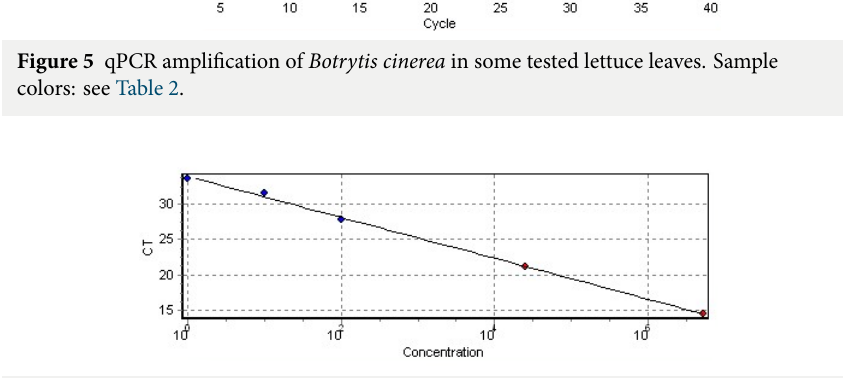
Figure 6 Standard curve revealed a linear relationship ( R 2 = 0.97) between the DNA concentration of serial dilutions of target genomic DNA of Botrytis cinerea and the cycle